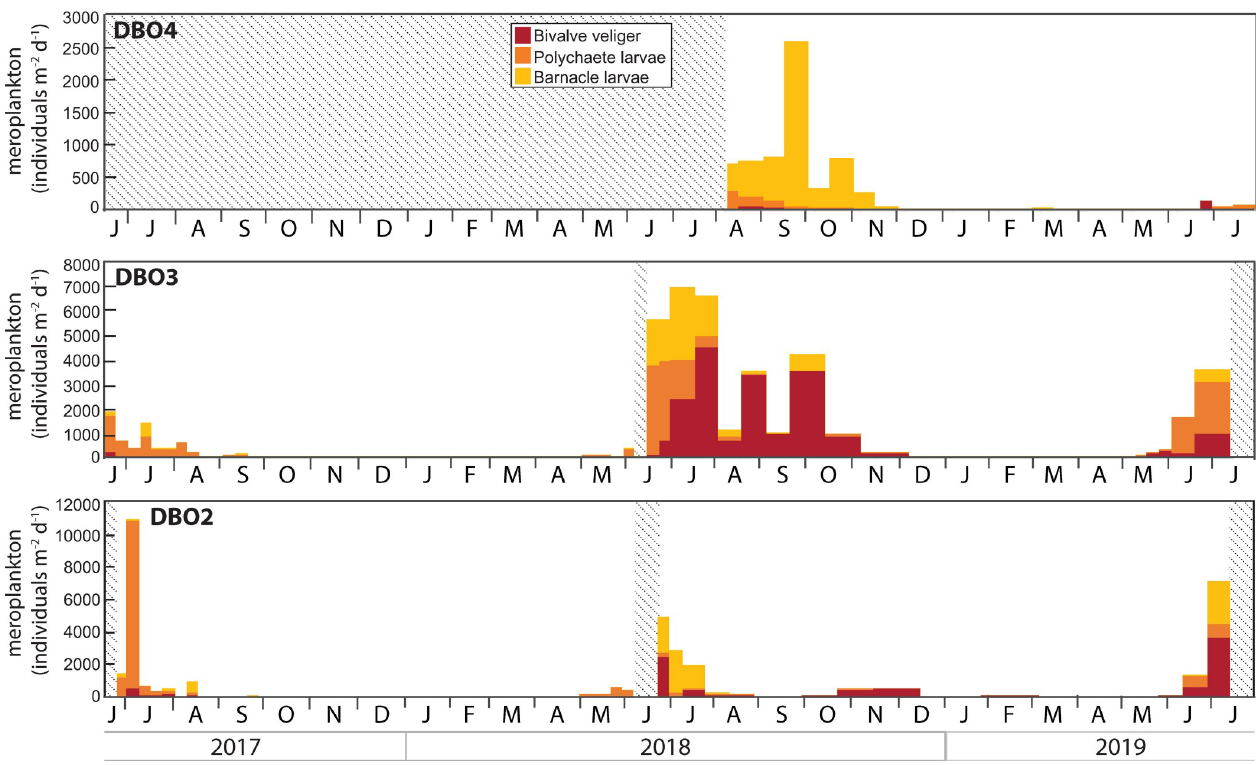
Fig 8. Meroplankton larvae collected in the sediment trap at each mooring site. Note the different scales. Shaded areas represent periods without